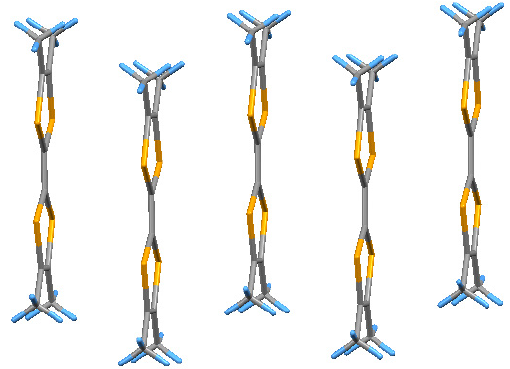
Figure 8. A stack of radical-cations in ( 3 ).